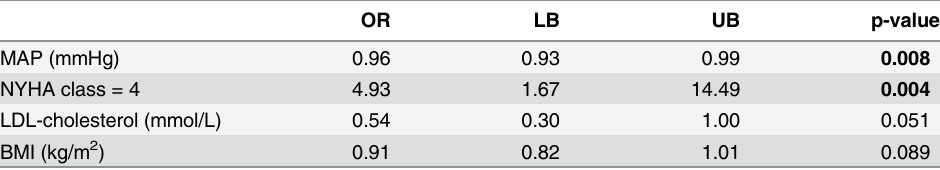
Table 4. Multivariable logistic regression analysis of hospital mortality.